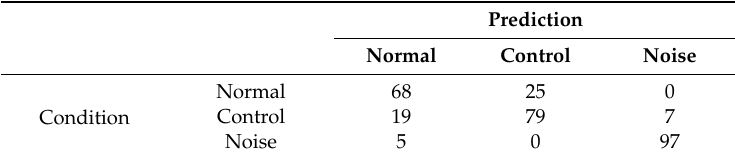
Table 4. Result of confusion